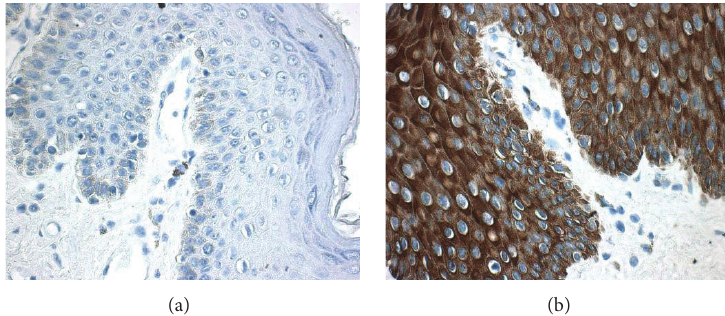
Figure 5: Immunohistochemical analysis of the expression of interferon- (IFN-) 𝜆 1 in human epidermis tissue. The tissue was fixed with Carnoy’s solution and stained with (a) or without anti-IFN- 𝜆 1 antibody (negative control) (b). Positive stained cells were in brown. Magnification was ×